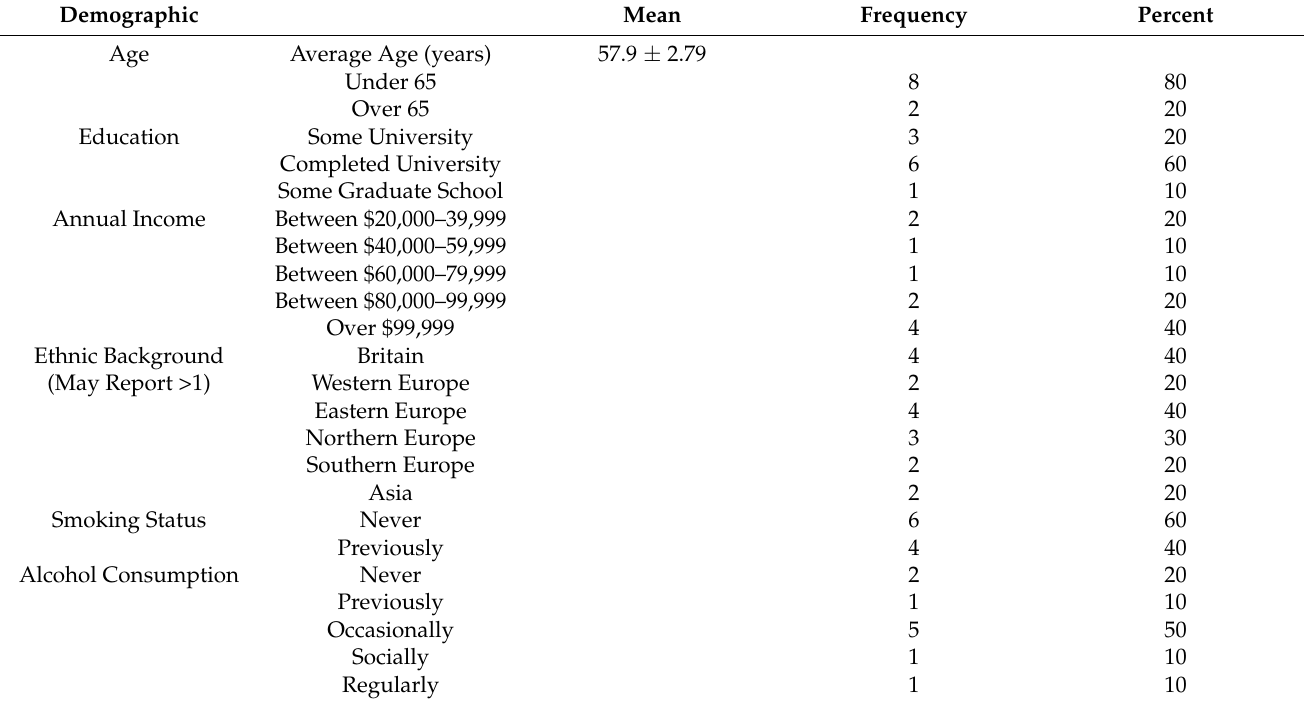
Table 3. Demographic information on participants recruited from the Alberta Cancer Exercise (ACE) program ( n =